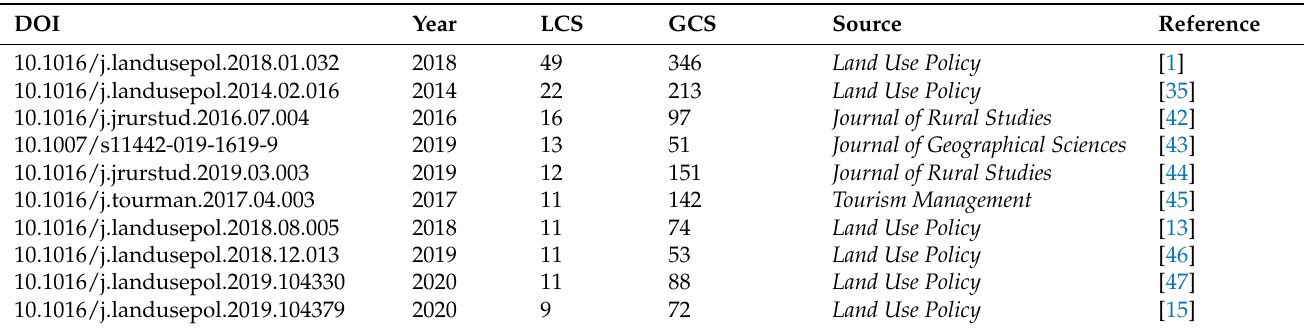
Table 2. Highly cited articles in the field of rural revitalization from 1991 to 2021 (Top 10). LCS = number of local citations; GCS = global citation score.